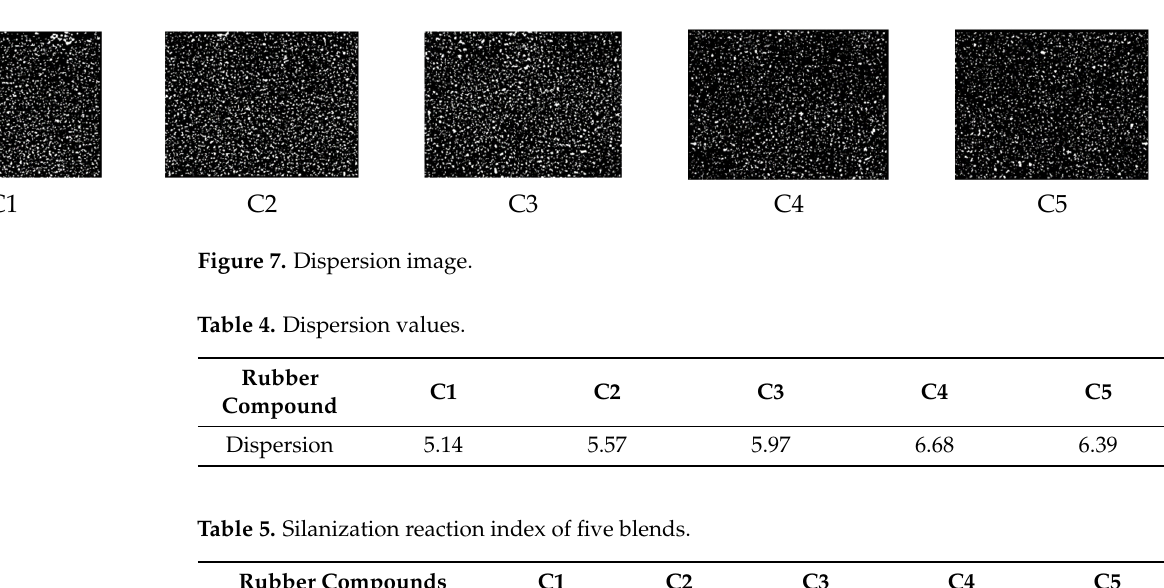
Figure 6. Microstructure of the aramid fiber (20× magnification).